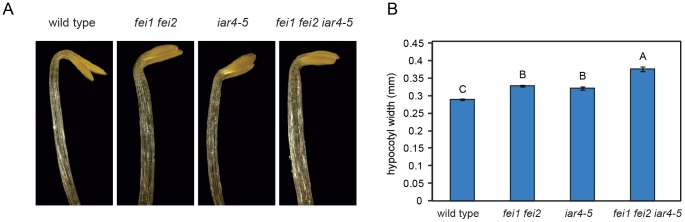
Effect of iar4-5 mutation on the hypocotyl phenotype of fei1 fei2.(A) Seedlings of the indicated genotypes were grown for four days in the dark on MS medium with 0% sucrose. Representative seedlings were imaged using dark field microscopy. (B) Quantification of hypocotyl widths from seedlings grown as in (A). Values represent the mean (n = 20) ± SE. Different letters indicate significant differences between groups. Data were analyzed with one-way ANOVA and Tukey's post-hoc comparisons; P<0.05.